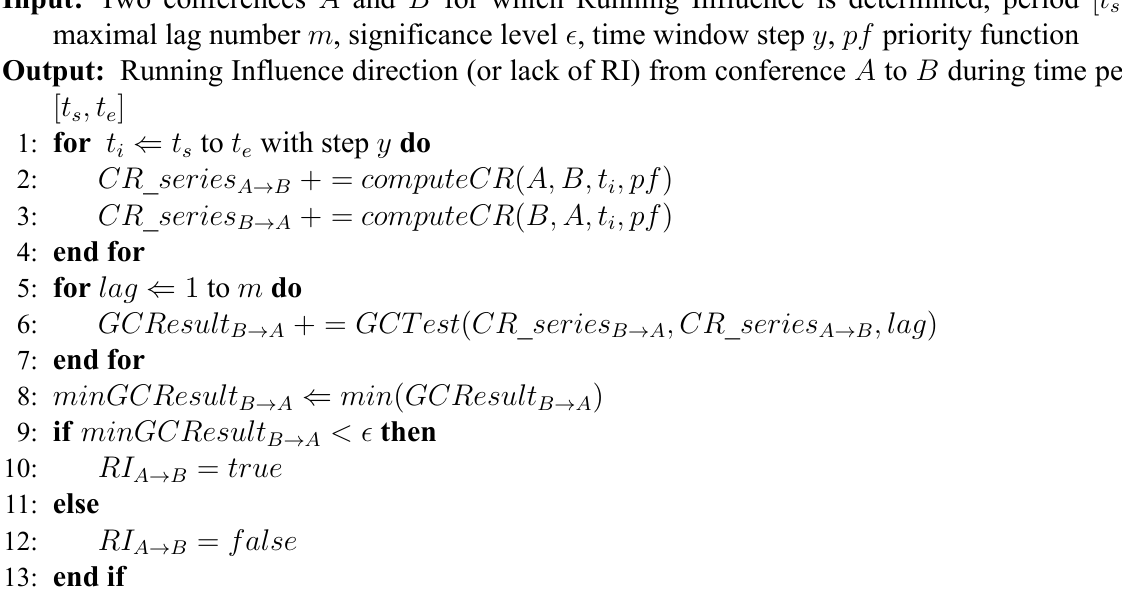
Algorithm 2 Method for determining Running Influence from conference A to B – whether conference A influences conference